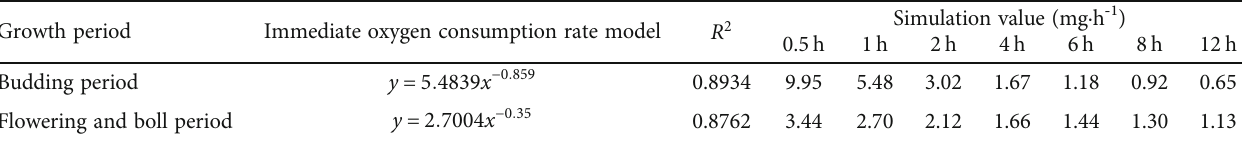
Table 3: Simulation table of instantaneous oxygen consumption rate per cotton